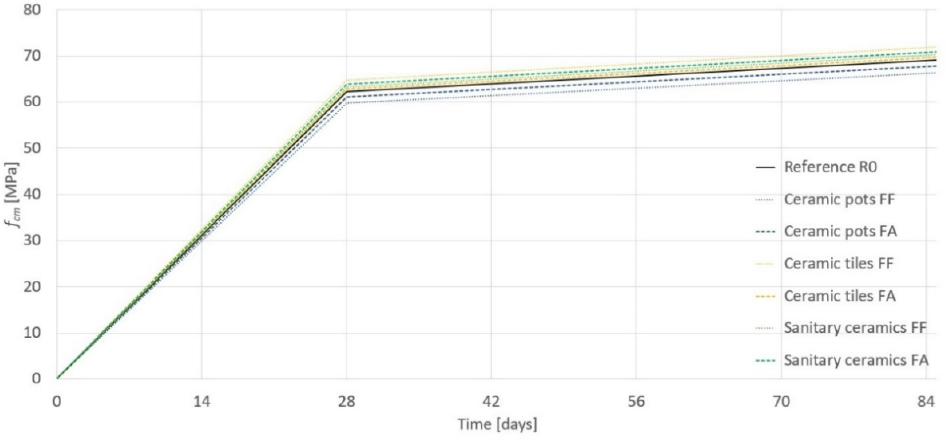
Figure 5. The development of the compressive strength over time.